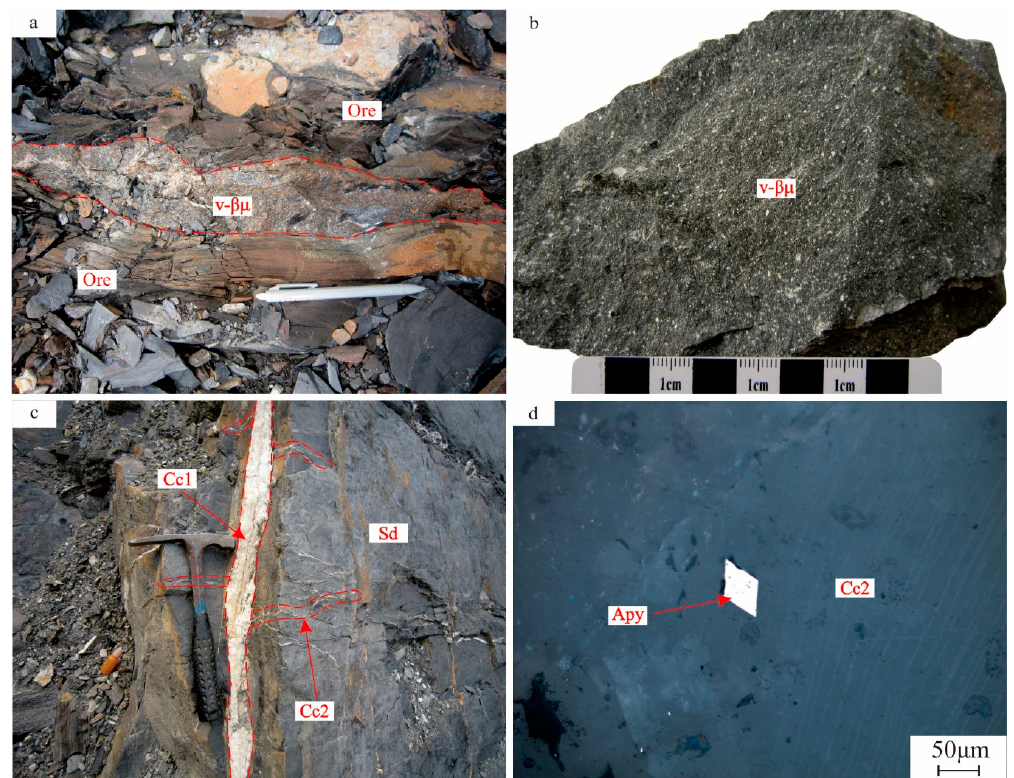
Figure 4. ( a ) Field photograph of diabase and its relationship with gold ore; ( b ) hand specimen of the diabase; ( c ) field photograph of ore-stage calcite with alteration halo and are crosscut by the post-ore calcite; ( d ) photomicrograph of the textural relationships between euhedral arsenopyrite and ore-stage calcite (reflected plane polarized light); v βµ = diabase; Sd = Sandstone; Apy = Arsenopyrite; Cc1 = Ore-stage calcites; Cc2 = Post-ore